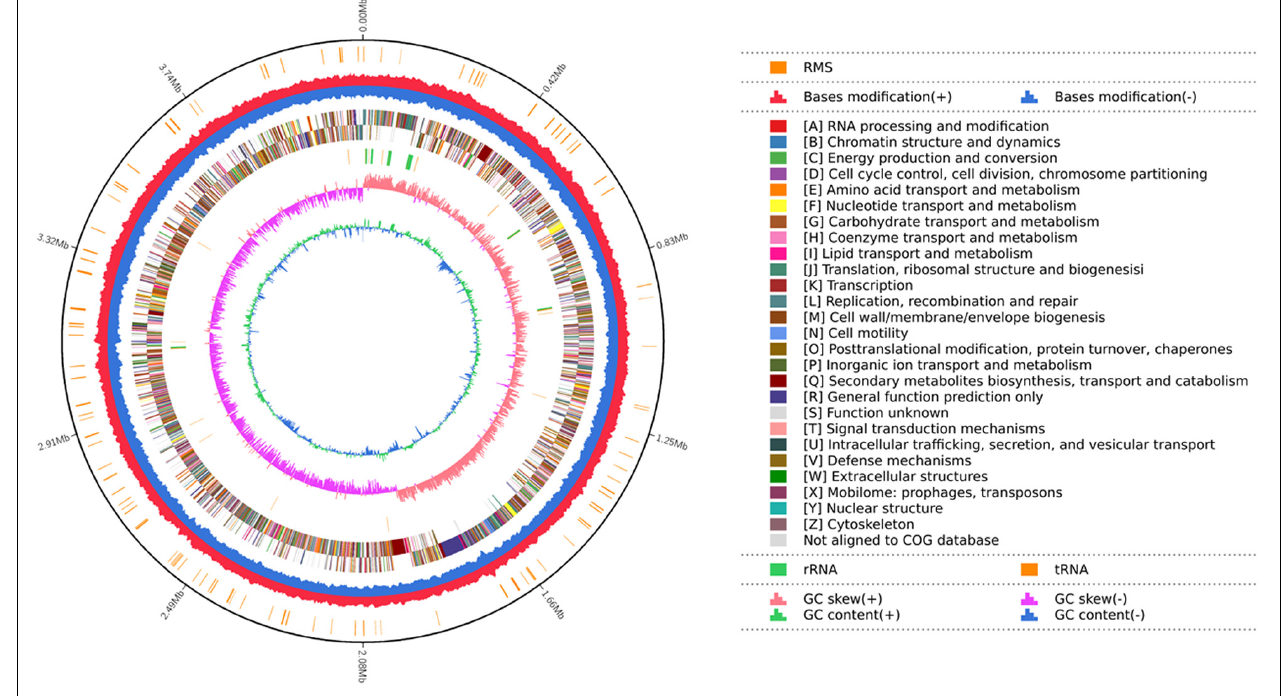
( Figure 3D ). In addition, it could produce siderophores ( Figure 3E ) and indole acetic acid ( Figure 3F ).